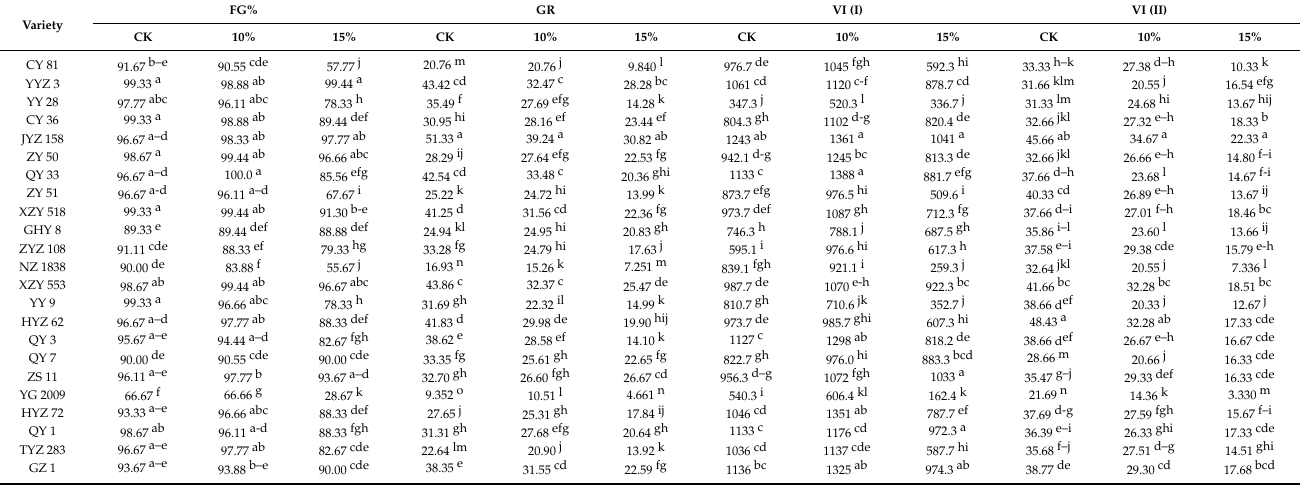
Table 1. Seed germination traits under different concentrations of PEG-6000-induced drought